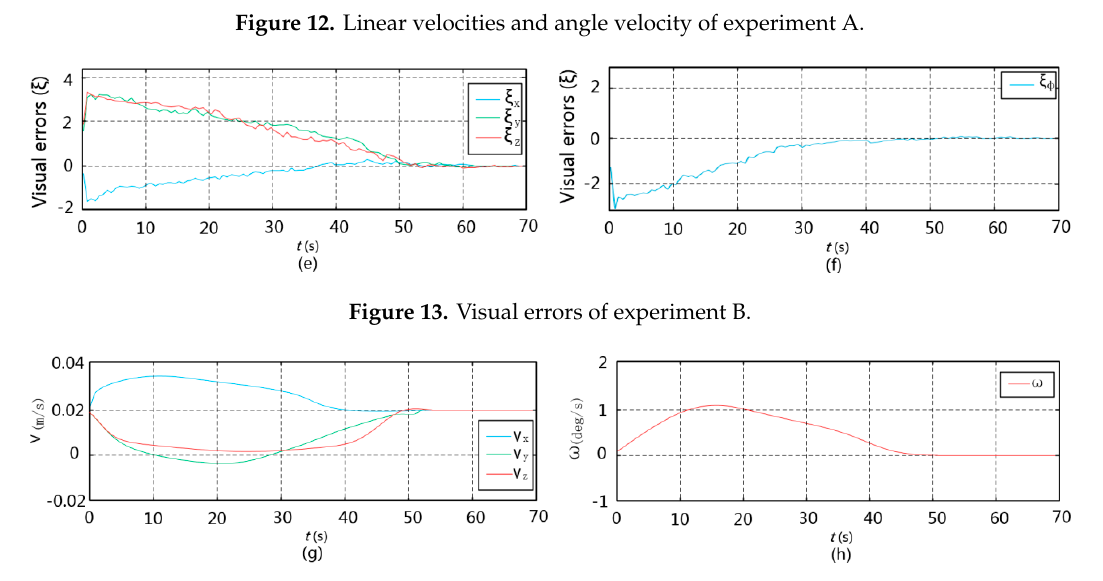
Figure 14. Linear velocities and angle velocity of experiment B.